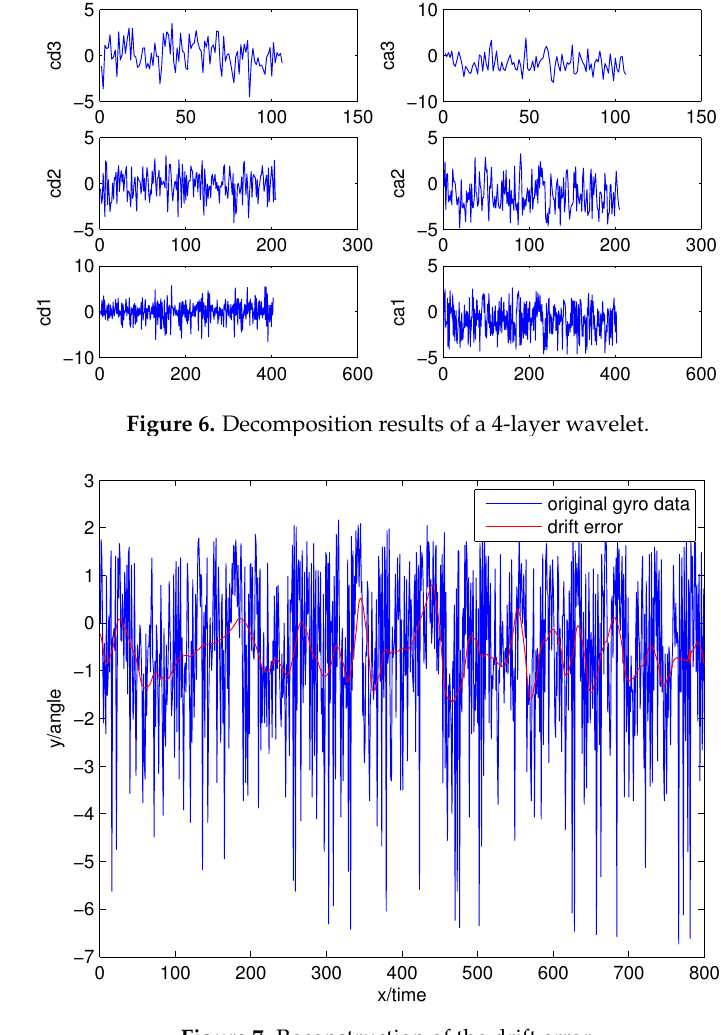
Figure 7. Reconstruction of the drift